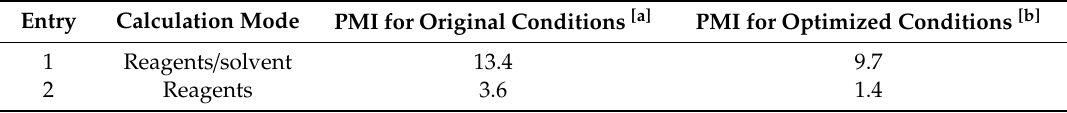
Table 4. PMI score for the conversion of vanillin in ferulic